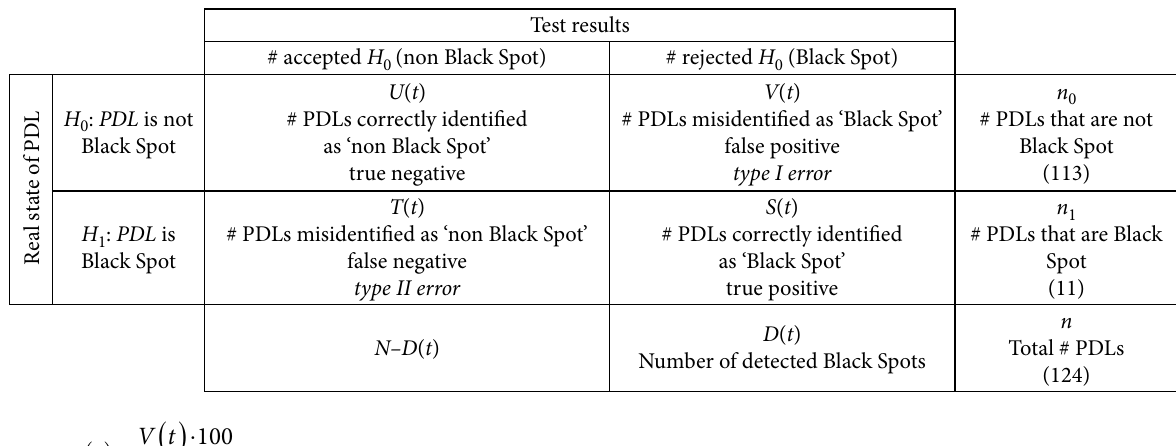
Table 2. The outcomes of the multiple hypothesis testing with the common threshold t (based on Miranda-Moreno et al. 2007) for n tests